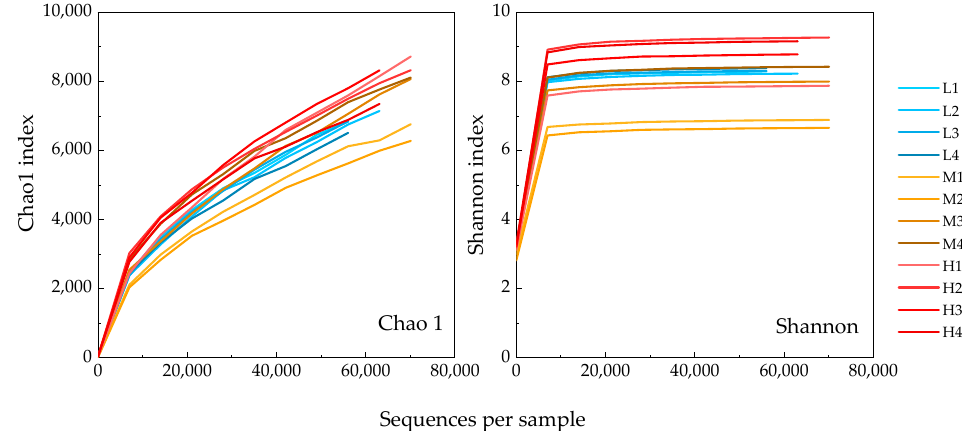
Figure 8. Rarefaction results of Chao1 and Shannon index of observed OTUs in all samples.